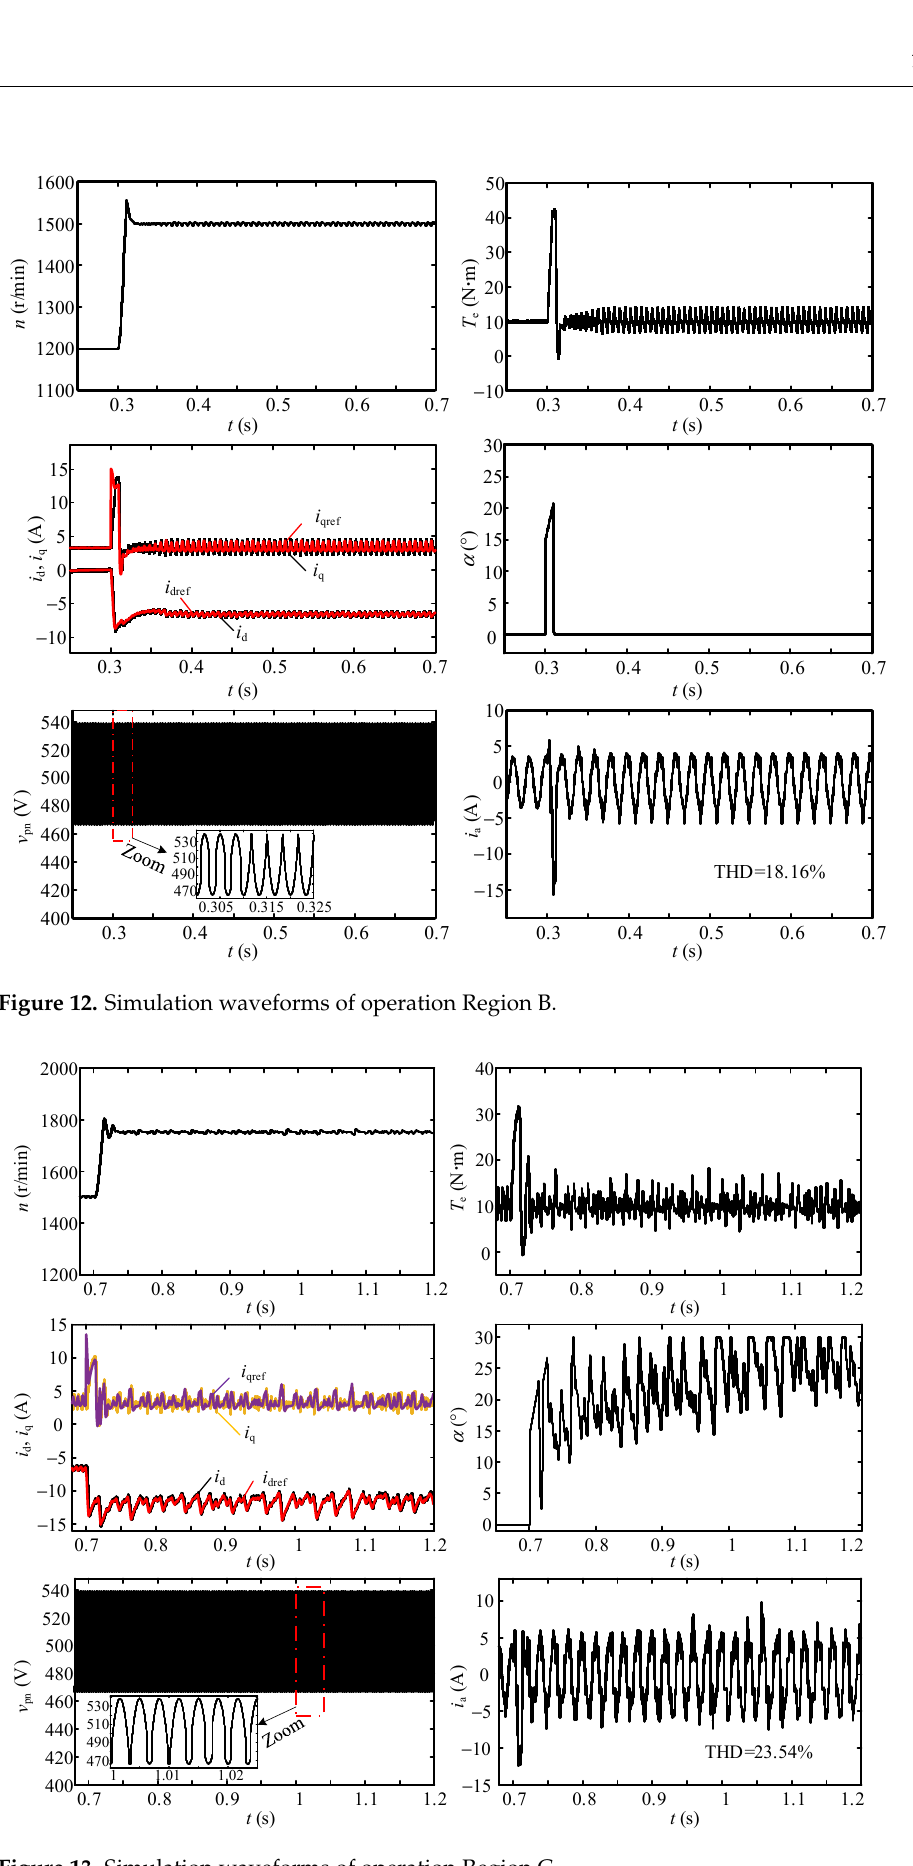
Figure 13. Simulation waveforms of operation Region